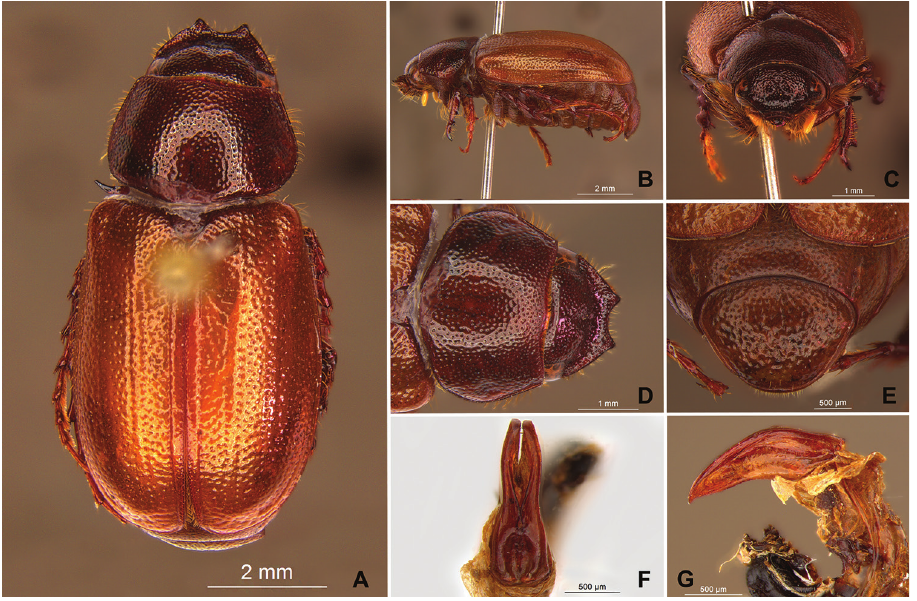
Figure 79. Liogenys cavifrons Cherman, sp. n. A Dorsal view B Lateral view C Frontal view D Clypeus and pronotum E Pygidium F Parameres, dorsal view G Parameres, lateral